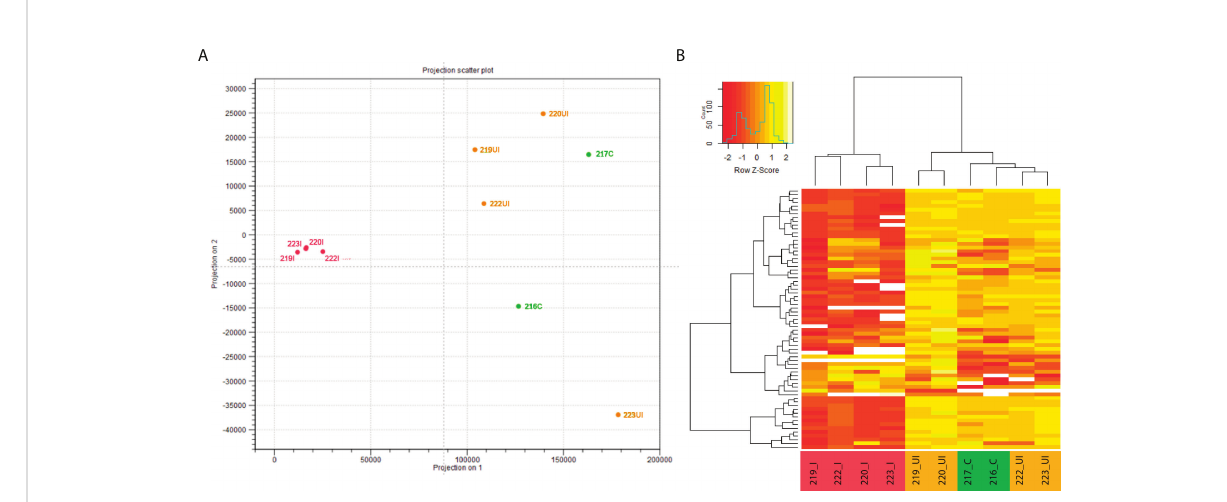
FIGURE 2 In silico performed PCA of individual miRNA expression data clustered samples into control, TNBS-treated unin fl amed and TNBS-treated in fl amed groups, while examination of signi fi cantly altered miRNAs con fi rmed these observations. (A) Principal component analysis (PCA) of individual rat colon samples and (B) representative heat map image of signi fi cantly altered miRNAs in the control (green, n=2), TNBS-treated unin fl amed (orange, n=4), TNBS-treated in fl amed (red, n=4) tissues. Heat map contains 68 miRNAs that displayed signi fi cant expression change (white representing missing values). Abbreviations “ C ” , “ UI ” and “ I ” in sample IDs represent control, unin fl amed and in fl amed sample groups,